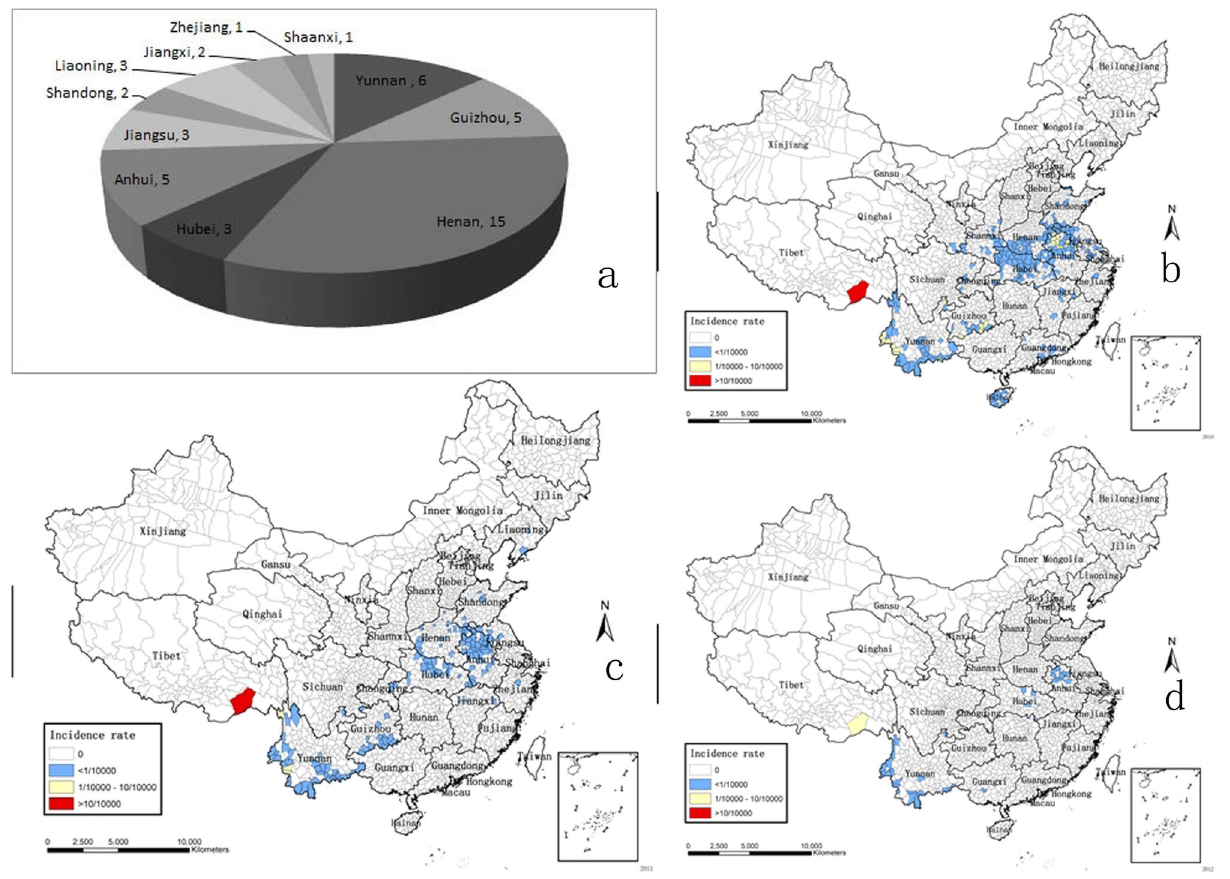
Figure 1. The Shifts of Counties with Different Malaria Incidence Rates. a: distribution of new counties suffered from autochthonous malaria in 2011; b-d: national distribution of counties at four malaria incidence rates in 2010, 2011, 2012